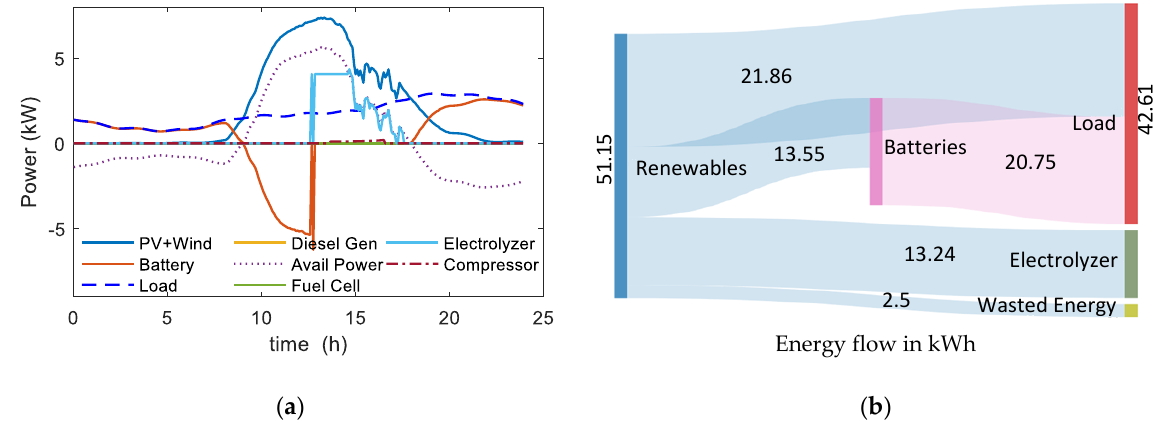
Figure 7. Node 3 at isolated daily operation (NMPC off): ( a ) Systems operation; ( b ) Energy flow (kWh).